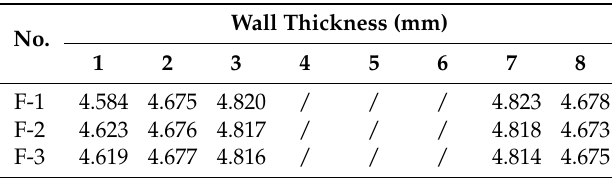
Table A1. Testing results for Field K.